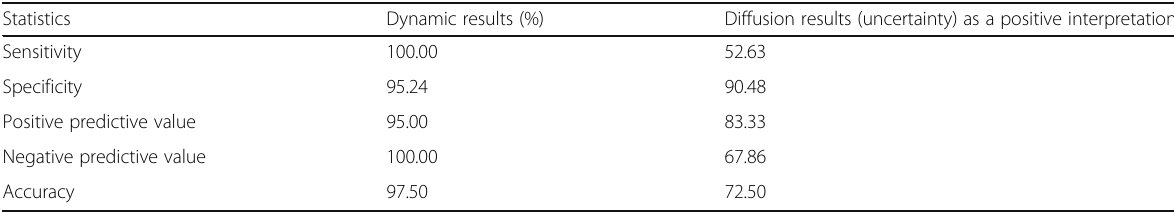
Table 6 Different indices of the dynamic MRI and the DWI